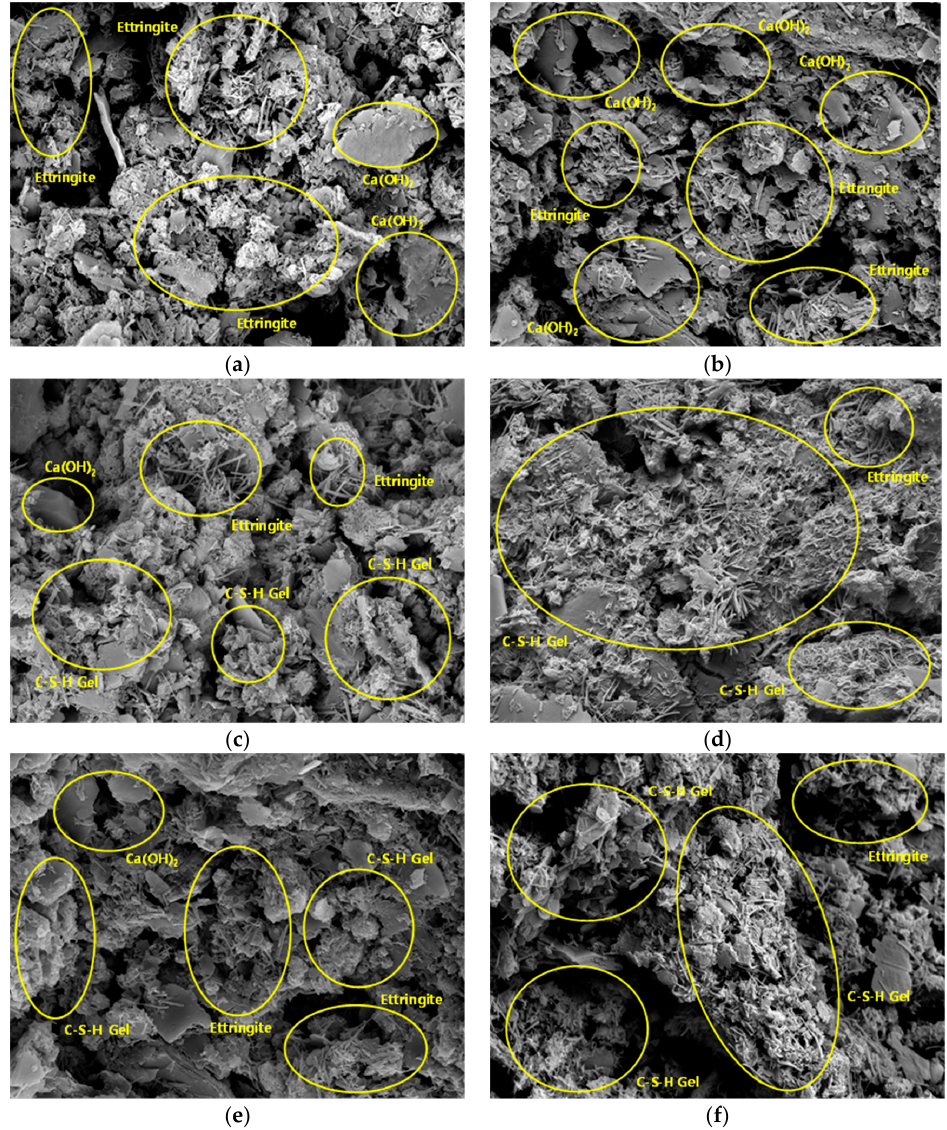
Figure 6. 7-d SEM images for different W/B values (×10,000). ( a ) W/B = 500%; ( b ) W/B = 450%; ( c ) W/B = 400%; ( d ) W/B = 350%; ( e ) W/B = 300%; ( f ) W/B = 250%.